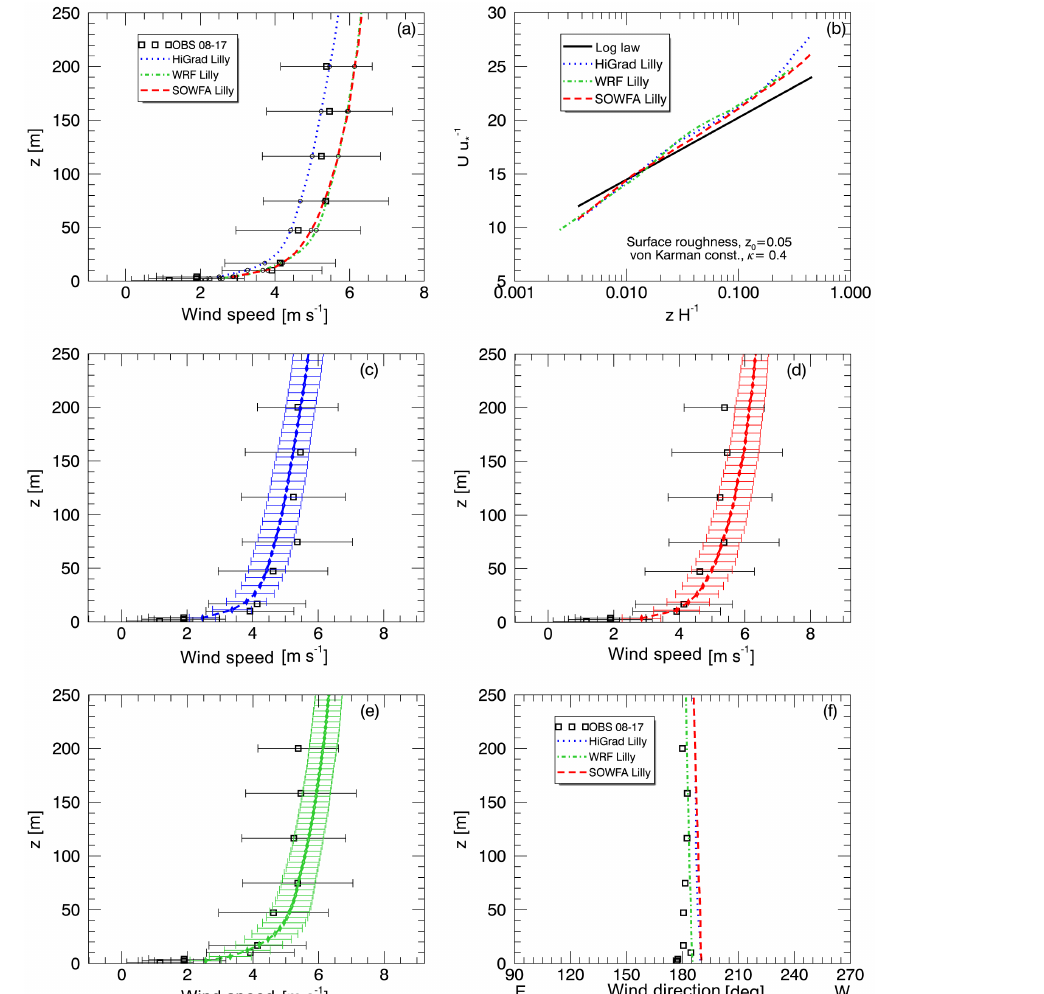
Figure 10. Observed and simulated wind speed and direction, from the neutral case study, using higher resolution, with each solver using its optimal aspect ratio and the Lilly SFS model. Top panels show each models’ mean wind speeds against observed variability (a, c, e) and the theoretical logarithmic distribution (b, d, f) . Middle and lower panels show each models’ mean and variability relative to the observations, with wind direction shown in the lower